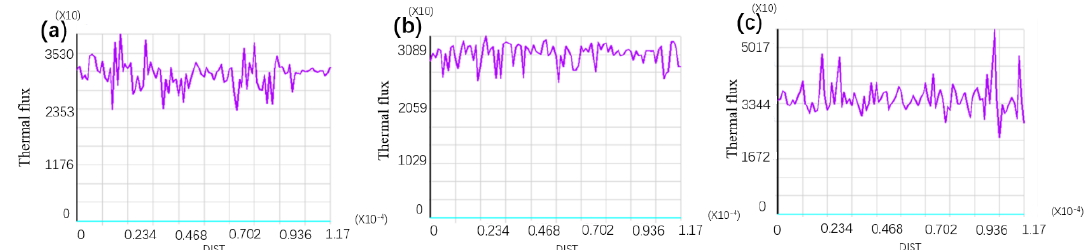
Figure 8. Distributions of thermal flux on the materials without monoclinic phase ( a ) M 1 , ( b ) M 2 and ( c ) M 3 .